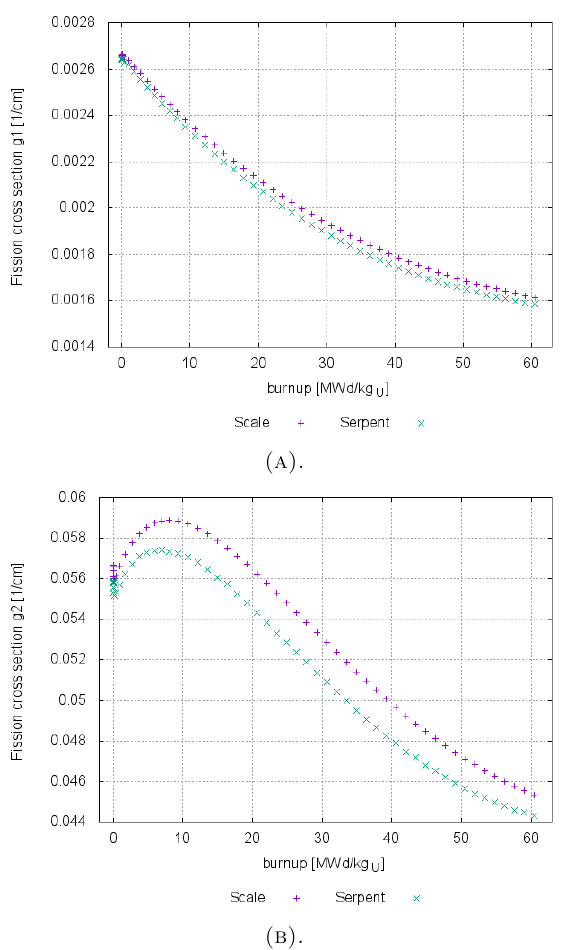
Figure 6. SCALE fission cross-section discrepancy to Serpent values for fast group (a) and for thermal group